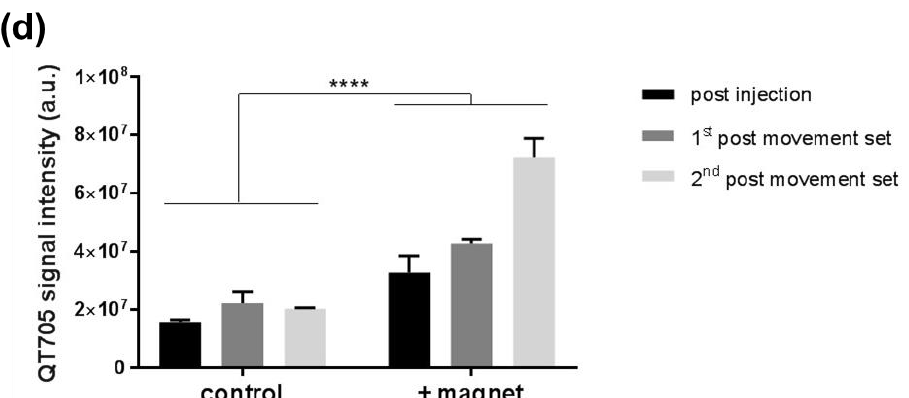
Figure 4. Whole body imaging of MP-labelled cells injected into a rat model. ( a ) QT705 (red) used for fluorescence labelling of MSCs, shown with Phalloidin staining (green) and dapi (blue) counterstain. Bar = 25 µ m. ( b ) Peritoneal injection of MP-labelled (right) or unlabelled (left) MSCs in the presence of subcutaneously implanted magnets, imaged using the IVIS system. ( c ) MP-labelled cell suspension marked with QT705 assessed for fluorescence detection after subcutaneous injection in the hind limbs in the presence of dermally applied magnets. Imaging was carried out immediately after injection (top panel), after a first set of 20 bilateral leg flexion movements (middle panel), and after a second set of flexion movements post magnet removal (bottom panel). Bilateral comparison between cell fluorescence upon subcutaneous injection with (right) or without (left) magnet application. ( d ) Relative increase in QT705 fluorescence signal observed in the presence ( + magnet) or absence (control) of a magnet, measured immediately after injection (post injection) or after 1 set (1st post-movement set) or 2 sets (2nd post-movement set) of flexion movements. **** p < 0.0001.